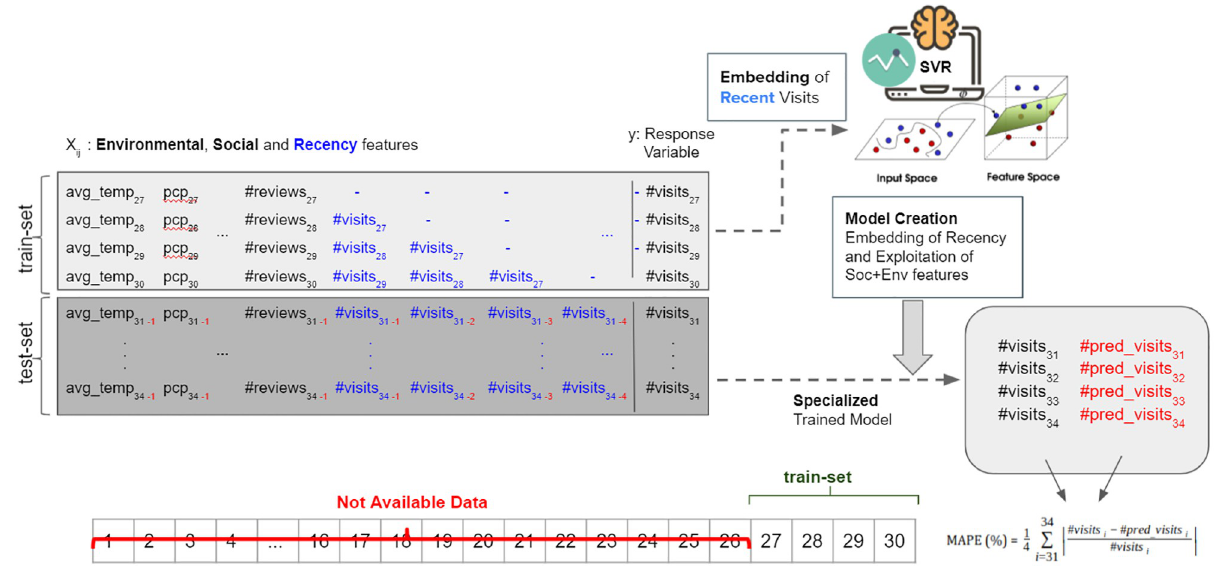
Fig 4. Tourism demand prediction methodology in scarcity of seasonal data adopting social media, environmental and recency features.